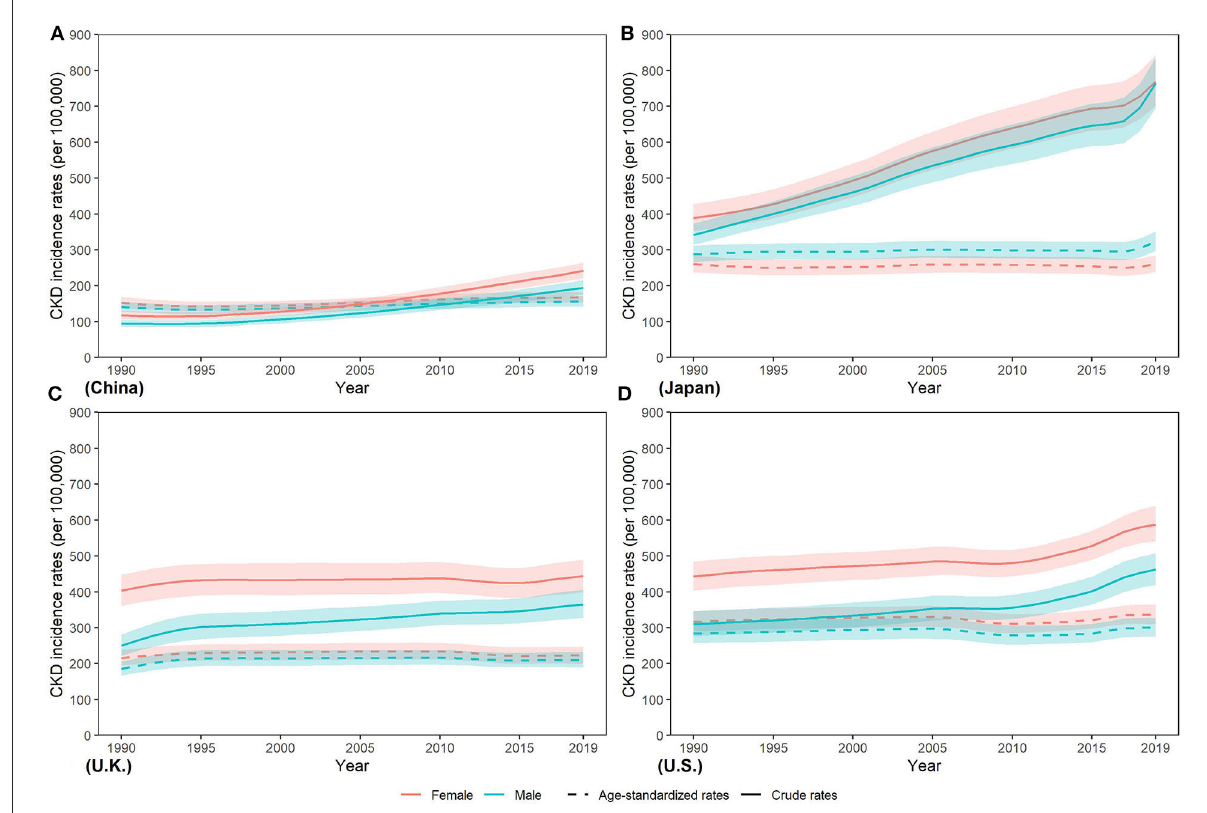
FIGURE2 Trends in CKD incidence rates from 1990 to 2019 in (A) China, (B) Japan, (C) U.K., and (D) the U.S.